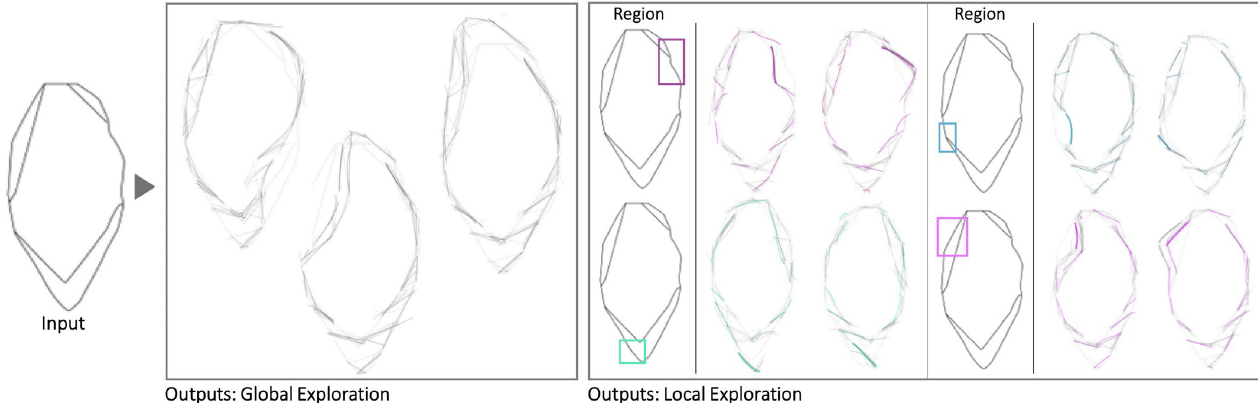
Fig 7. Some of the Global and Local shape variations generated with Shapi for the conceptual exploration of a hand-axe. The Seed is based on an exploration by a product & communication design student [86].